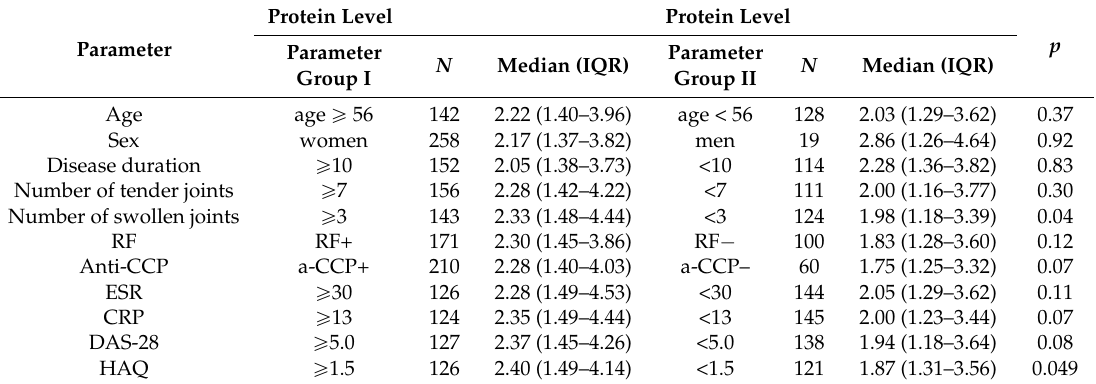
Table 6. The disease activity and laboratory parameters (RA phenotype) in relations to RORc level.